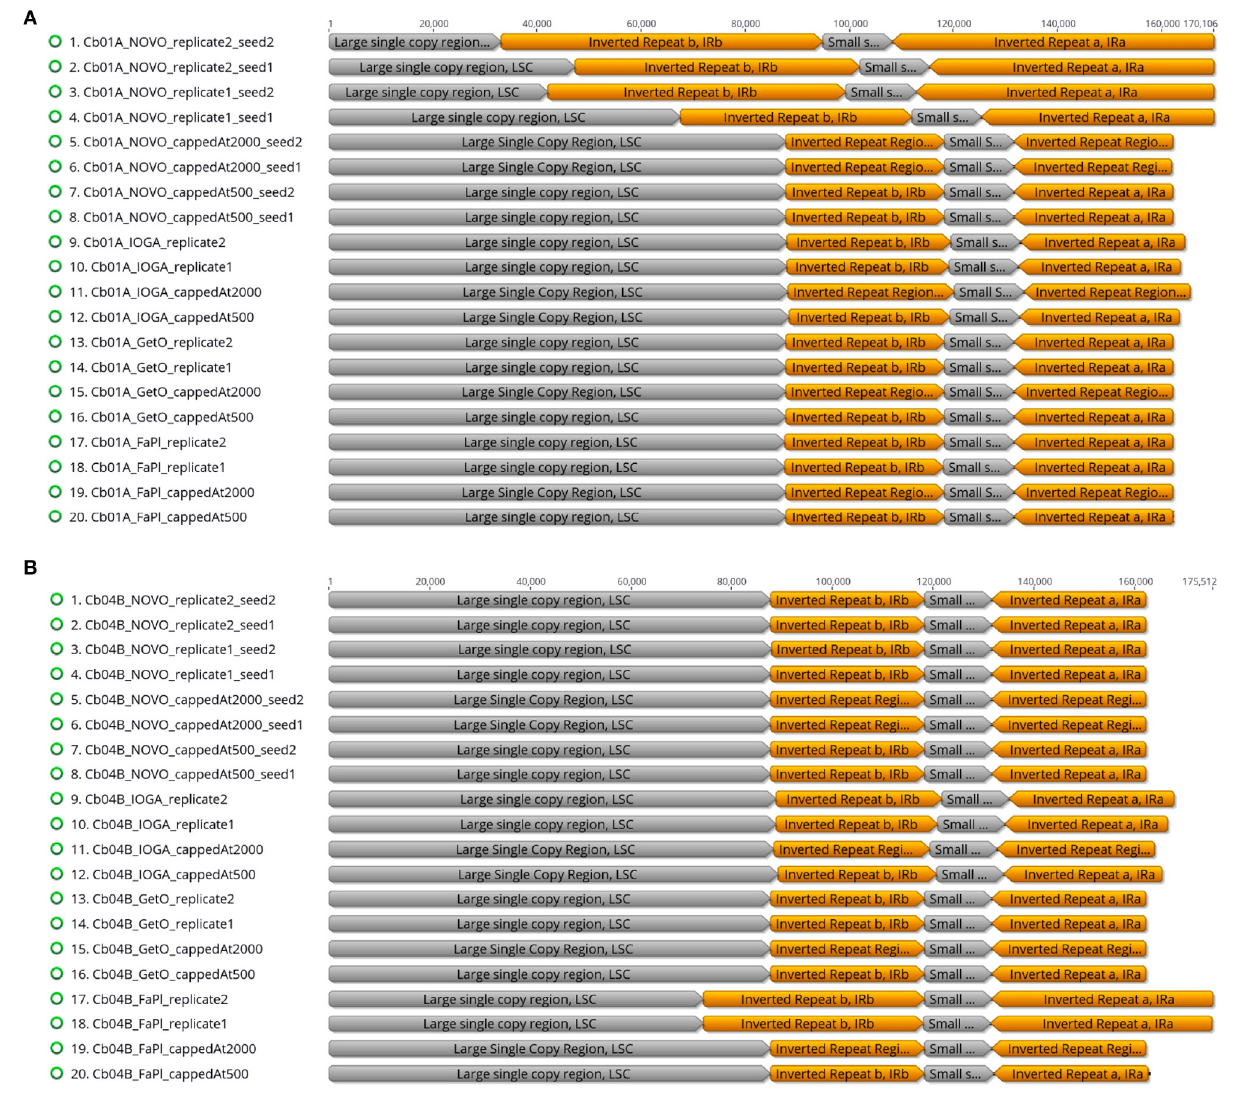
FIGURE 4 | Overview of the relative lengths of the LSC, the SSC, and the two IRs across the plastid genome assemblies of the individuals Cb01A (A) and Cb04B (B) of C. bakuense as generated by different assembly software and levels of sequencing